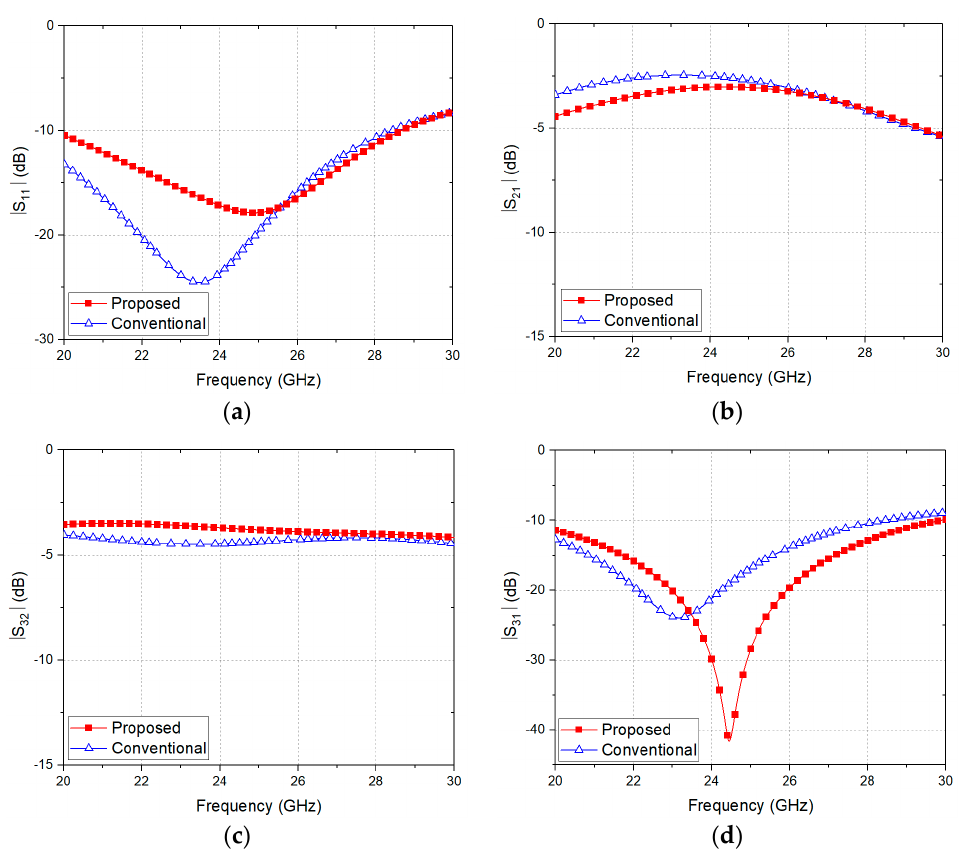
Figure 7. Simulated S -parameters of the proposed and conventional quasi-circulators at 24.125 GHz: ( a ) | S 11 |; ( b ) | S 21 |; ( c ) | S 32 |; ( d ) | S 31 |.